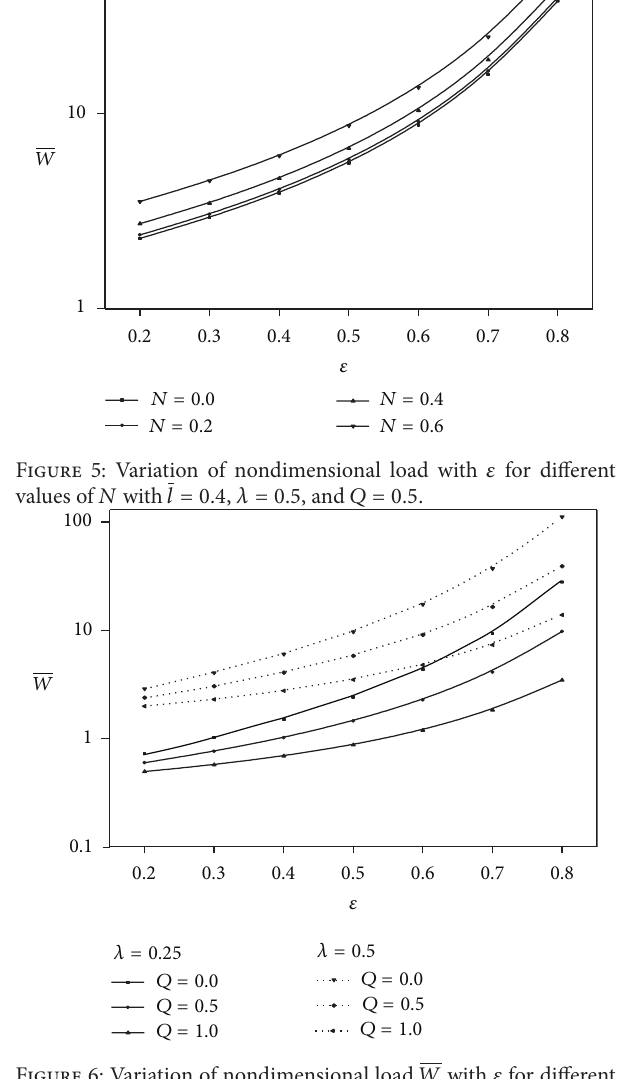
Figure 6: Variation of nondimensional load 𝑊 with 𝜀 for different values of 𝑄 with 𝑙 = 0.4 , 𝜆 = (0.5, 0.25) , and 𝑁 = 0.2 . 𝑙 = 0.4 , 𝑁 = 0.2 , 𝑄 = 0.5 , and 𝜆 = 0.5 . The effect of